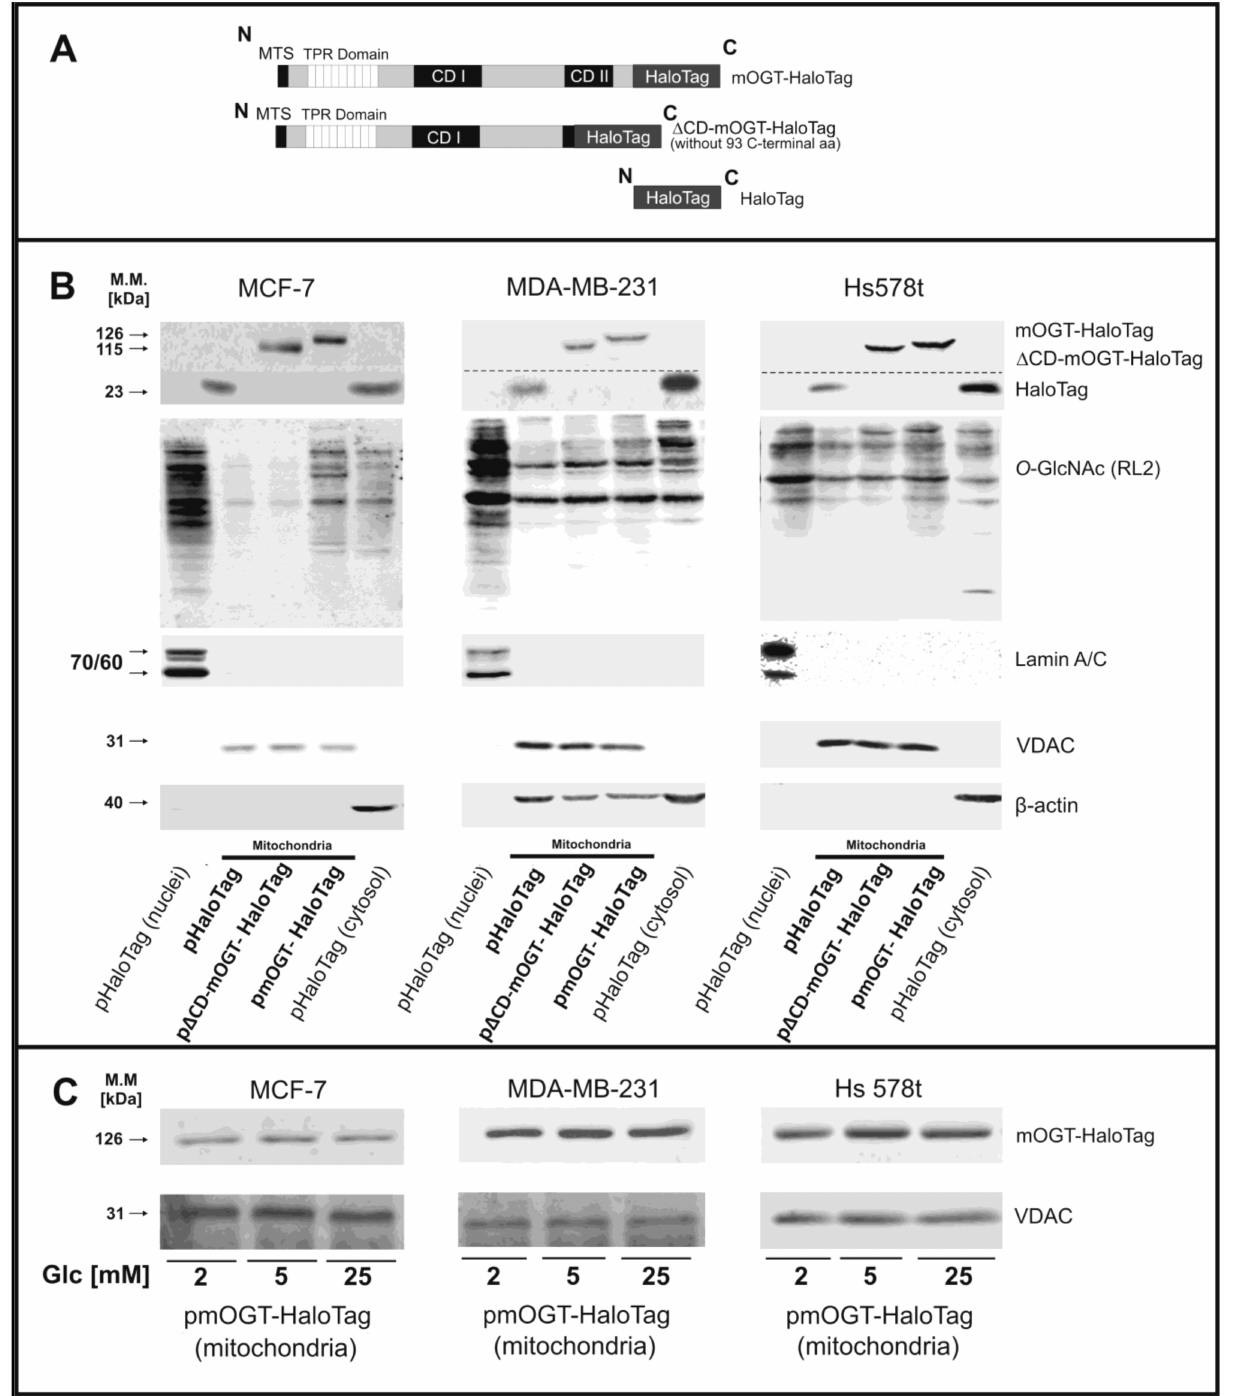
Figure 2. Up-regulated mOGT targets the mitochondria and modifies mitochondrial proteins in breast cancer cells. ( A ) The scheme of mOGT-HaloTag fused protein, its catalytic inactive mutant with truncated CDII domain, and HaloTag used as a control. ( B ) Expression of Halo-tagged proteins and O -GlcNAc level in mitochondria-enriched fractions 48 h after plasmid transfection of cells growing in hypoglycemia. Nuclei-enriched fraction and cytoplasm extract were loaded to assess the purity of mitochondria. VDAC, Lamin A/C, and β -actin were used as purity markers for mitochondria, nucleus, and cytoplasm, respectively. ( C ) Expression of mOGT-HaloTag in mitochondria-enriched fraction derived from cells cultured in hypo-, normo-, or hyperglycemia conditions. MTS, mitochondria-targeted sequence; TPR, tetratricopeptide repeats, CD, catalytic domain; Glc, glucose. (The original western blot images are shown in the File